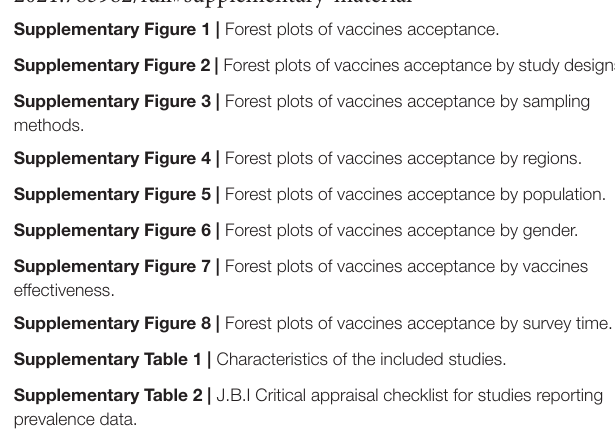
Supplementary Figure 2 | Forest plots of vaccines acceptance by study designs. Supplementary Figure 3 | Forest plots of vaccines acceptance by sampling methods. Supplementary Figure 4 | Forest plots of vaccines acceptance by regions. Supplementary Figure 5 | Forest plots of vaccines acceptance by population. Supplementary Figure 6 | Forest plots of vaccines acceptance by gender. Supplementary Figure 7 | Forest plots of vaccines acceptance by vaccines effectiveness. Supplementary Figure 8 | Forest plots of vaccines acceptance by survey time. Supplementary Table 1 | Characteristics of the included studies. Supplementary Table 2 | J.B.I Critical appraisal checklist for studies reporting prevalence